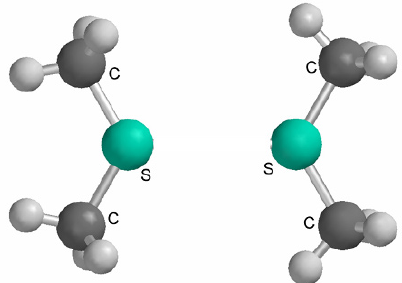
Figure 5. Dimer of dimethyl thioether, employed for computations shown in Table 1.